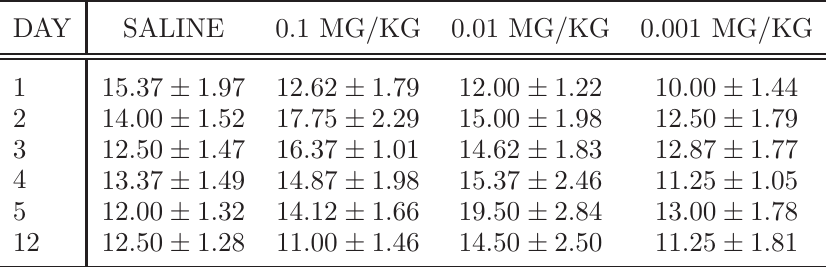
Table 1 Effects of CGP 63360 on active avoidance test.